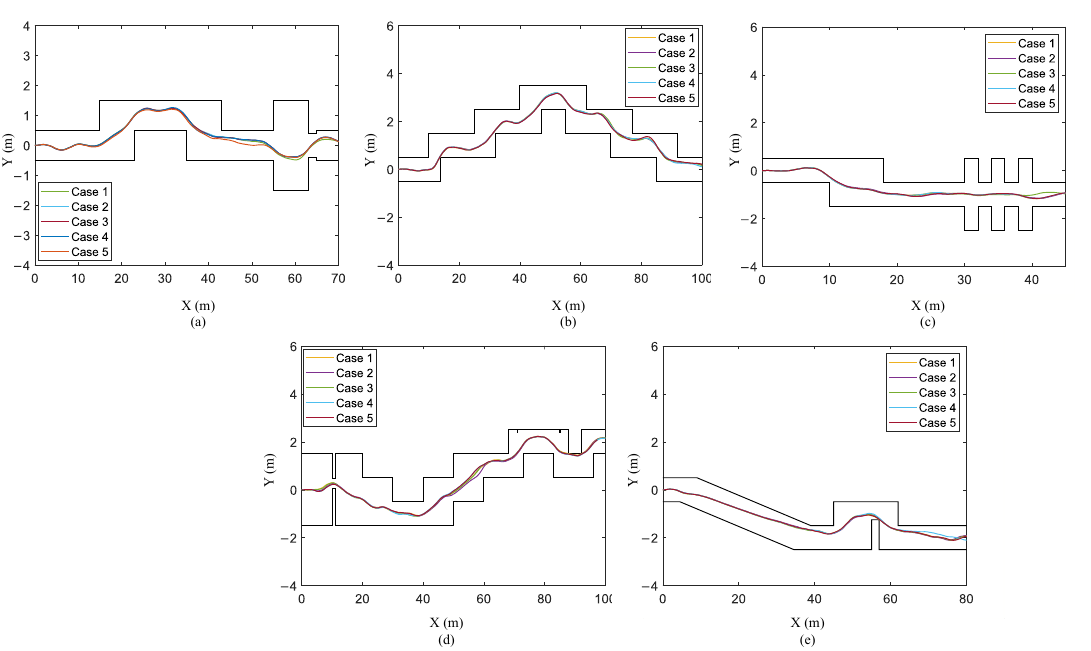
Figure 13. Trajectories of the STTW robot in test scenario II: ( a ) training terrain; ( b ) test terrain 1; ( c ) test terrain 2; ( d ) test terrain 3; ( e ) test terrain 4. (3)